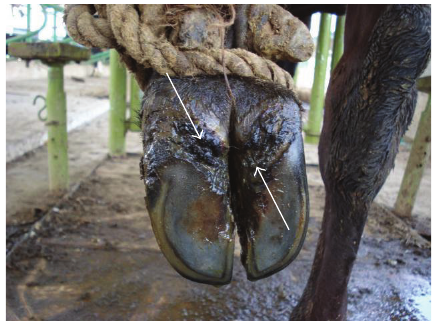
Figure 2: Heel erosion.